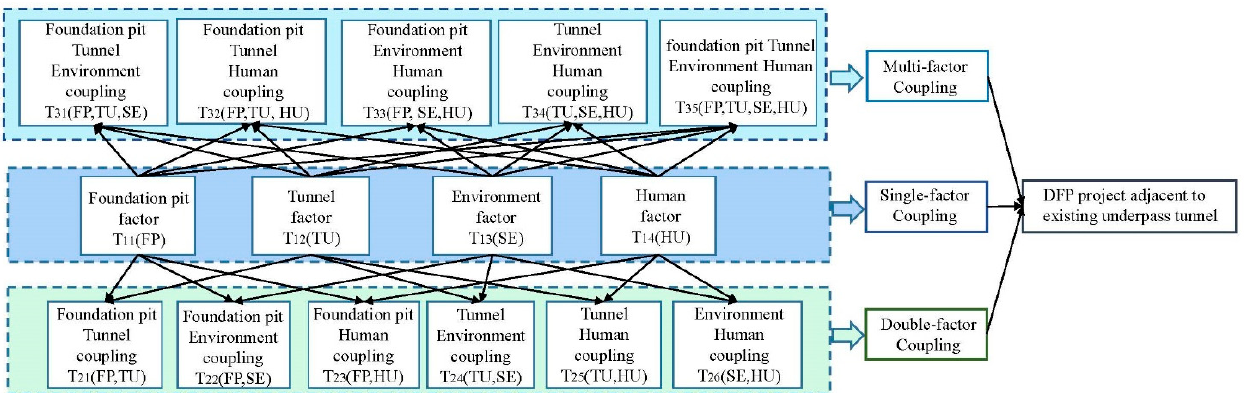
Figure 4. Types of risk coupling for accidents in deep foundation projects adjacent to existing underpass tunnels.